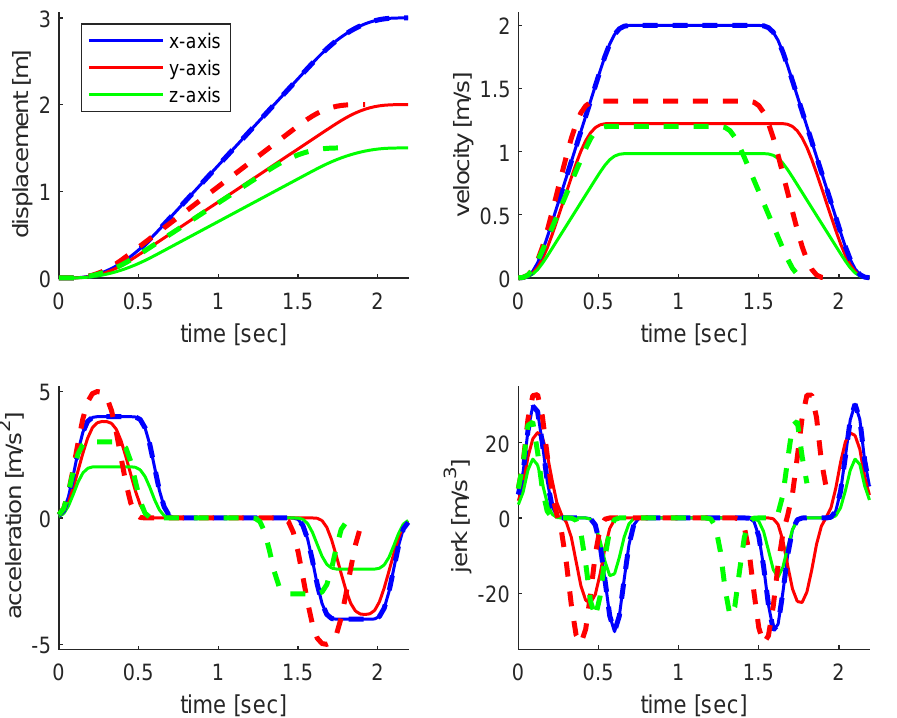
Figure 6. Comparison of the planned motion parameters along with a linear trajectory (solid lines— synchronized motion; dashed lines—unsynchronized motion).